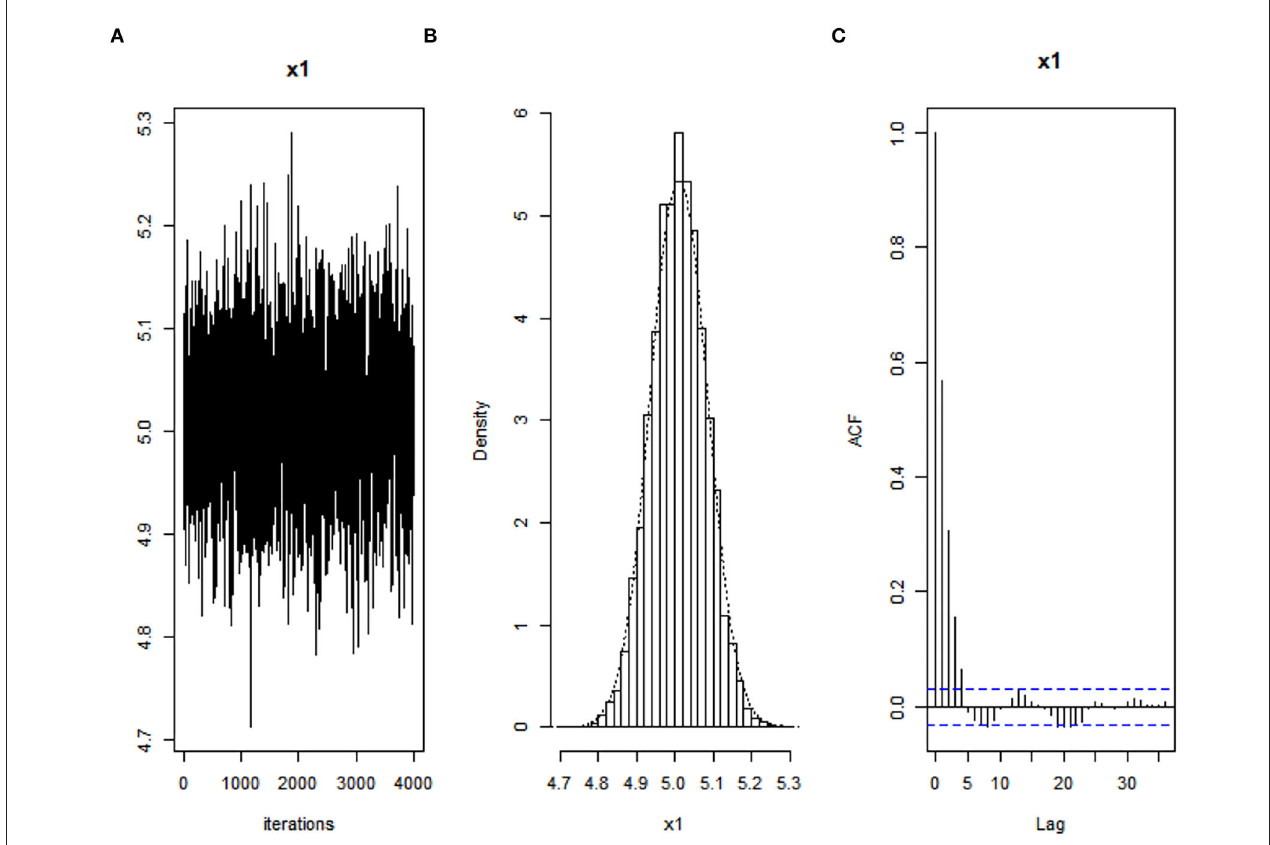
FIGURE 1 | Convergence diagnostics of parameter ˆ β 1 for heteroscedasticity error when τ (B) density plot, and (C) autocorrelation